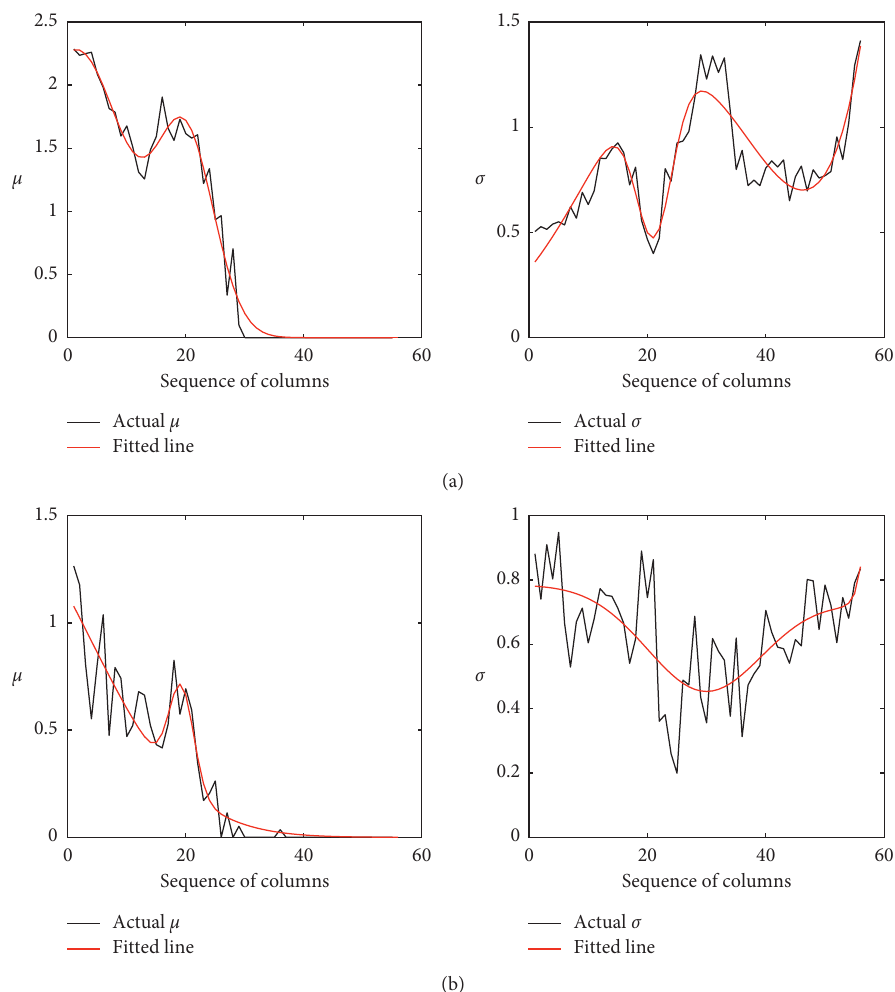
Figure 13: Variations of parameters μ k and σ k with respect to time instant. (a) CHB002EW and (b)